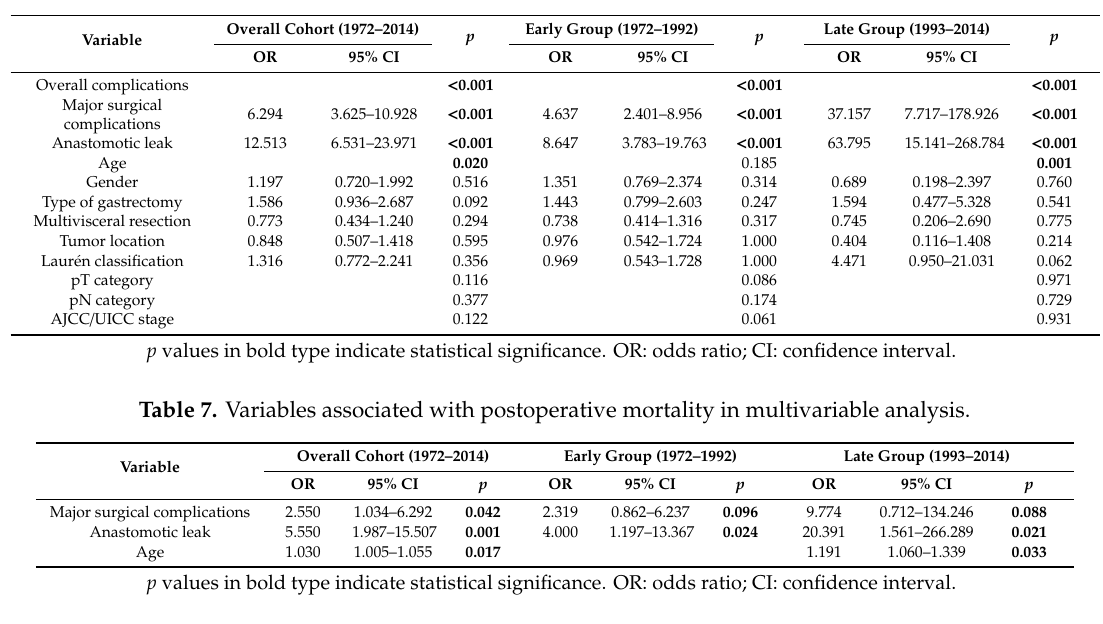
Table 6. Variables associated with postoperative mortality in univariable analysis.